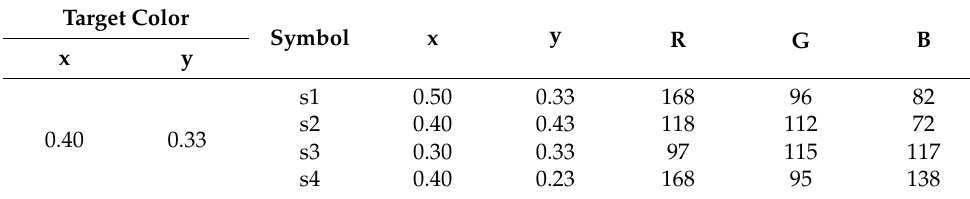
Table 4. Target color and symbol information.